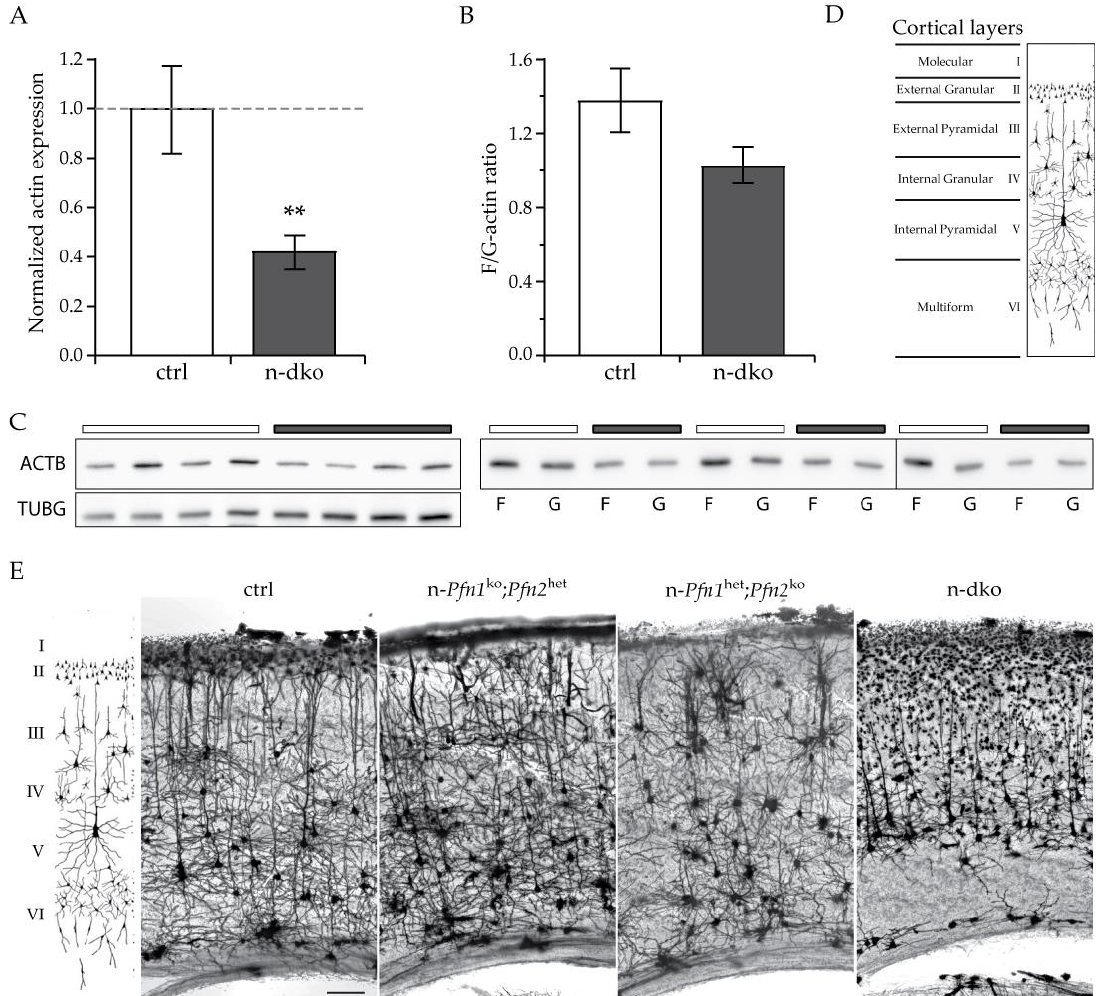
Figure 6. Reduction in total and filamentous actin affects neuronal morphology and survival in the cortex of n-dko mice. ( A ) Total actin (ACTB) in cortical extracts is reduced by 60% in n-dko mice compared to controls (one-sided Welch’s t -test, p = 0.0268, n = 4 per genotype). Actin levels were calibrated according to γ -tubulin (TUBG) expression. ( B ) The filamentous to monomeric actin ratio (F/G-actin ratio) is reduced in n-dko mice compared to controls; n = 3 per genotype. Error bars represent the SEM. ( C ) Western blots used for the quantifications shown in ( A , B ). ( D ) Schematic drawing illustrating the mouse cortical layers as they would appear in a Golgi staining. ( E ) Sample images of matched Golgi-stained cortical coronal slices in the motor cortex region of ctrl, n- Pfn1 ko ; Pfn2 het , n- Pfn1 het ; Pfn2 ko , and n-dko P80–90 mouse brains. The scheme on the left is the same as in ( D ) and helps in discriminating the neuronal layers in the Golgi-stained cortical columns shown on the right. A progressive loss of neuronal cell bodies and dendritic arborization can be seen as profilin levels decrease in the four panels from left to right, particularly evident for the neurons of the upper layers II and III. Scale bar: 100 µm; ** p ≤ 0.01.